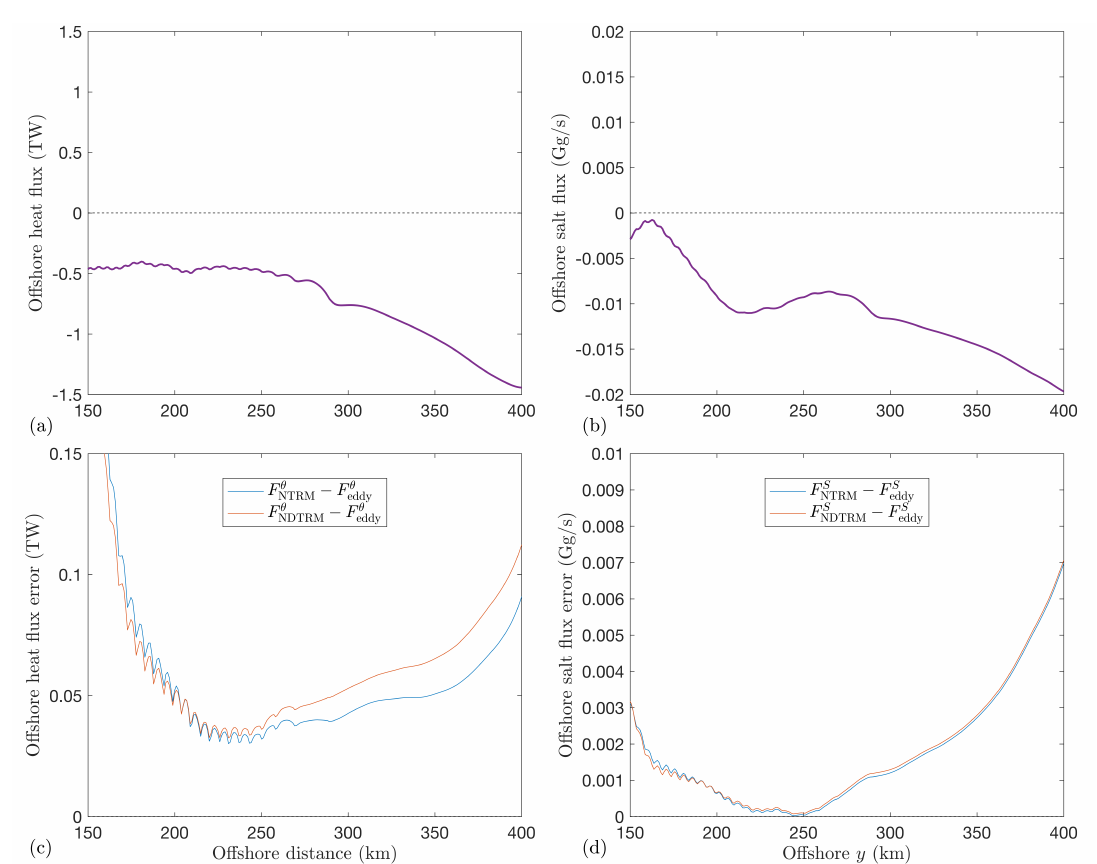
Figure 5. Comparison between cross-slope heat and salt fluxes diagnosed directly from the model output vs. estimated using TRM streamfunctions (see Section 4). Fluxes are plotted over a subset of the model domain in which the eddy transport was found to be primarily advective, rather than diffusive [42]. ( a , b ) Diagnosed offshore heat and salt fluxes, respectively. ( c , d ) Differences between diagnosed and NTRM-/NDTRM-estimated offshore heat and salt fluxes,